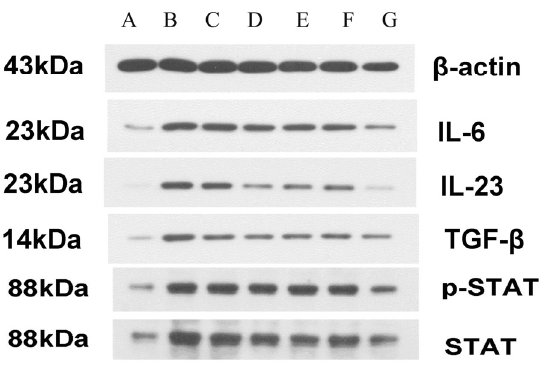
Figure 5. Western blots of IL-6 , IL-23 , TGF- β , STAT3 , and P-STAT3 in each group (Lane A control group; Lane B DSS group; Lane C placebo group; Lane D Mesalazine group;